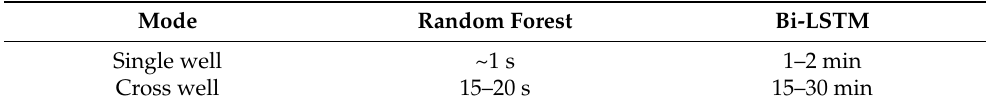
Table 7. Average computational